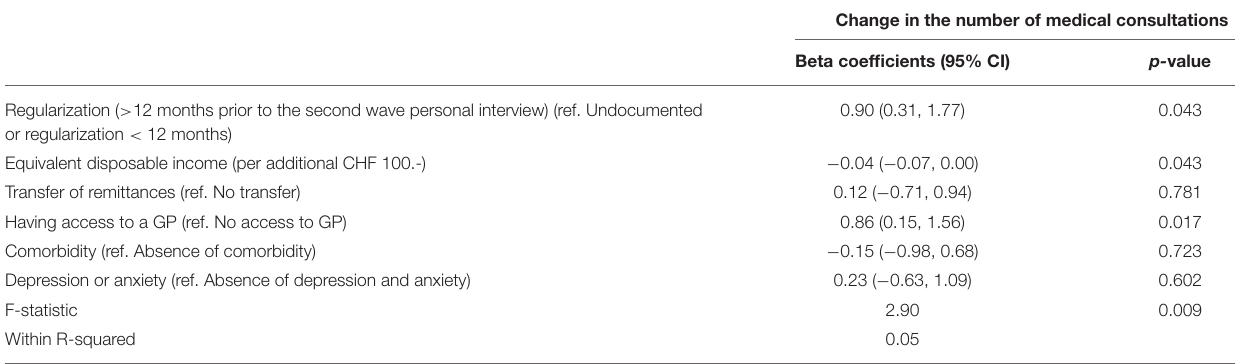
TABLE 5 | Within-individual variation in healthcare utilization according to residence status regularization, enabling and health needs